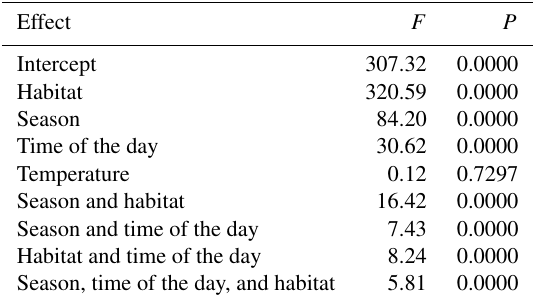
Table 1. The values of the F test for factors included in the model. Table 2. The mean distance (mh − 1 ) covered by horses depending on habitat, time of the day, and season.